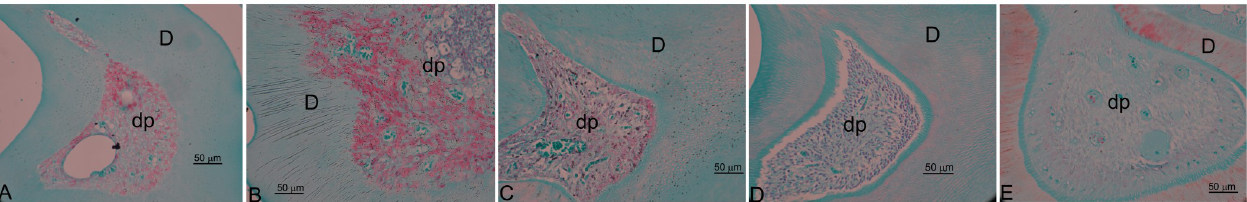
Fig 5. Safranin O and fast green staining to examine acidic proteoglycan expression in DSPP KO, Strain A, Strain B and wt mice at 21-day and 3-month. (A) 21-day DSPP KO M1 showed positive Safranin O staining. (B) 21-day Strain B M1 showed positive Safranin O staining. (C) 3-month Strain B M1 showed positive Safranin O staining. (D) 3-month Strain A showed M1 no Safranin O staining. (E) 3-month wt M1 showed no Safranin O staining. All images at 400x magnification.